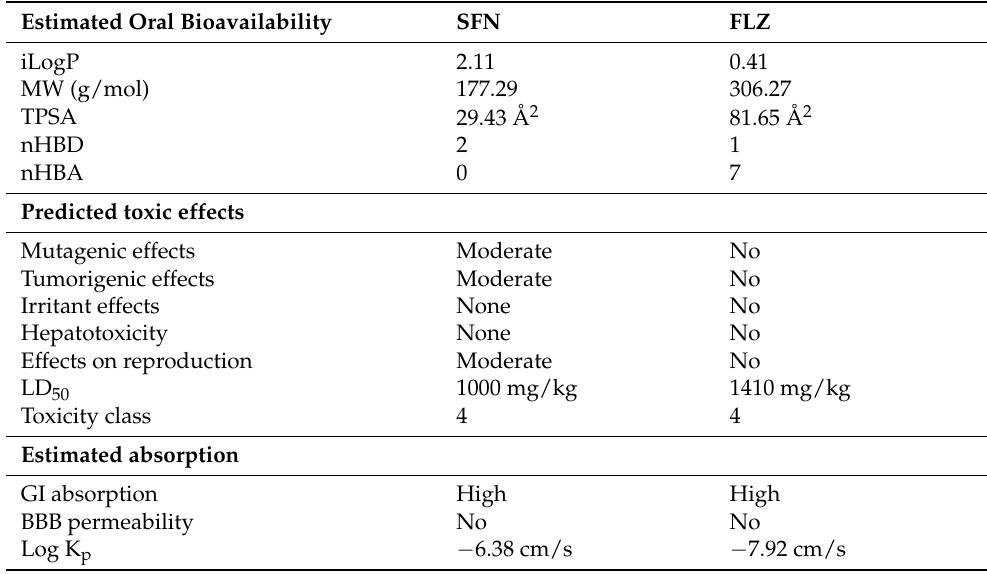
Table 2. In silico estimations of the oral bioavailability, toxic effects, absorption, solubility, and drug-likeness score of sulforaphane in comparison with